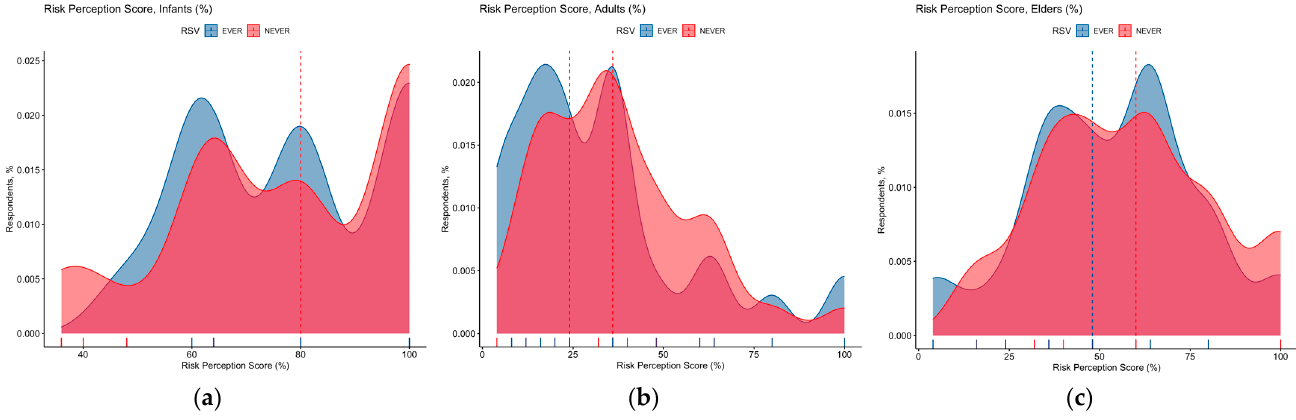
Figure 5. Density plot for Risk Perception Score (RPS) in infants ( a ), adults ( b ), and elderly ( c ) in 389 Italian Pediatricians participating into the survey. Cumulative scores were substantially skewed for infants (D’Agostino–Pearson’s normality test: p value 0.006) and adults ( p < 0.001), but not for elderly ( p = 0.594). When samples were broken down by having or not having previously cared for respiratory syncytial virus cases, no substantial differences in RPS were reported for infants (78.4% ± 17.8 vs. 78.3% ± 20.8; Mann–Whitney test p value 0.432), and elderly (53.6% ± 23.6 vs. 57.9% ± 23.9; p = 0.187). On the contrary, RPS for adults was substantially lower among participants having cared for RSV cases (32.7% ± 24.9) than among those having not (37.4% ± 21.3, p = 0.004).